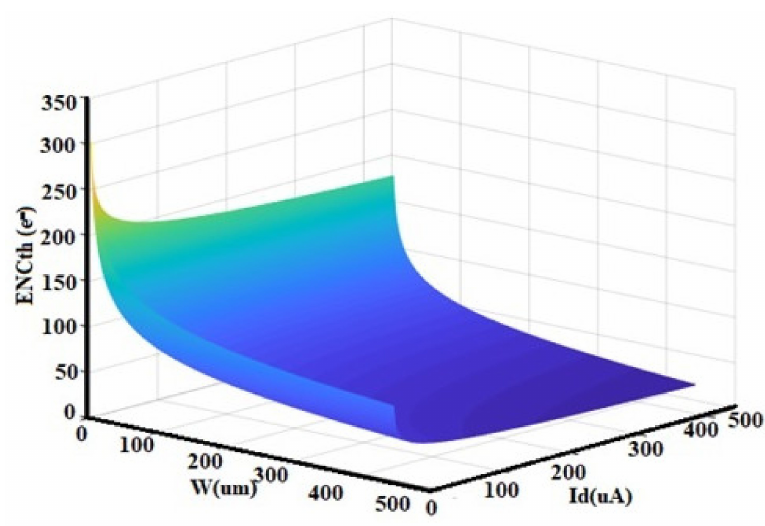
Figure 10. ENCth as a function of W and drain current (Id) [6].